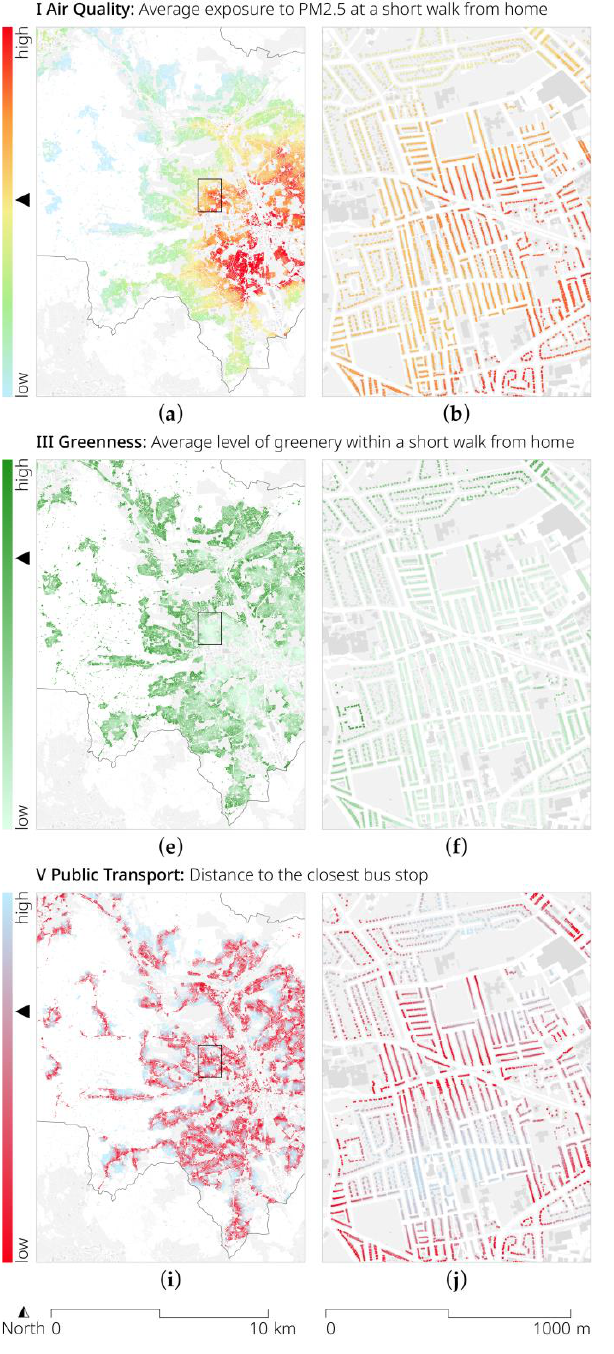
Figure 5. Visualisation of the selection of exemplary EIs (I – IV, see Table 2 for details) for the entire metropolitan district of Bradford and a detailed zoom-in on the Toller ward. EIs include: ( a,b ) average exposure to PM 2.5; ( c,d ) number of vehicles during the morning period; ( e,f ) average level of greenery; ( g,h ) distance to the closest public park or garden; ( i,j ) distance to the closest bus stop; and ( k,l ) distance to the closest fast-food outlet. © OS and Crown copyright 2022.